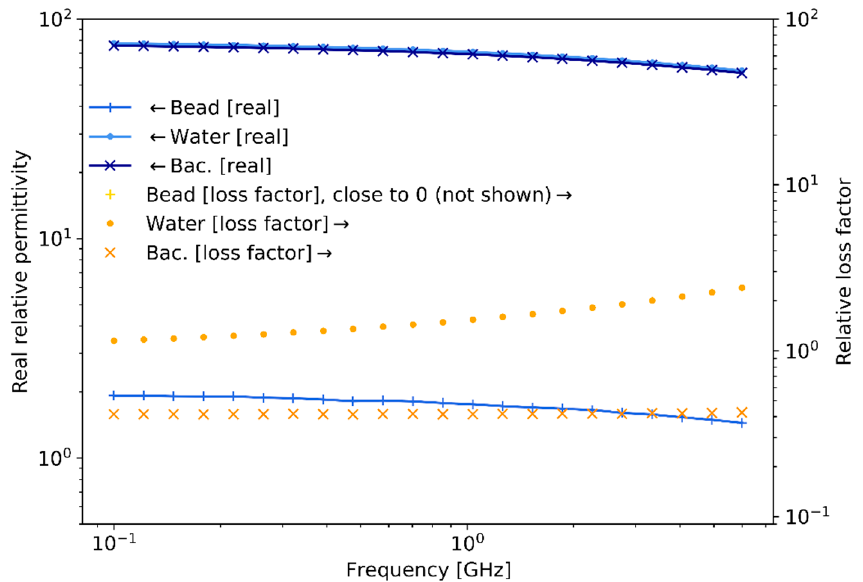
Figure 9. Microwave complex relative permittivity for different media. Measured complex relative permittivity of water, beads and bacteria in the range 0.1–6 GHz using the techniques described in [63,64], which are in concordance with [29].